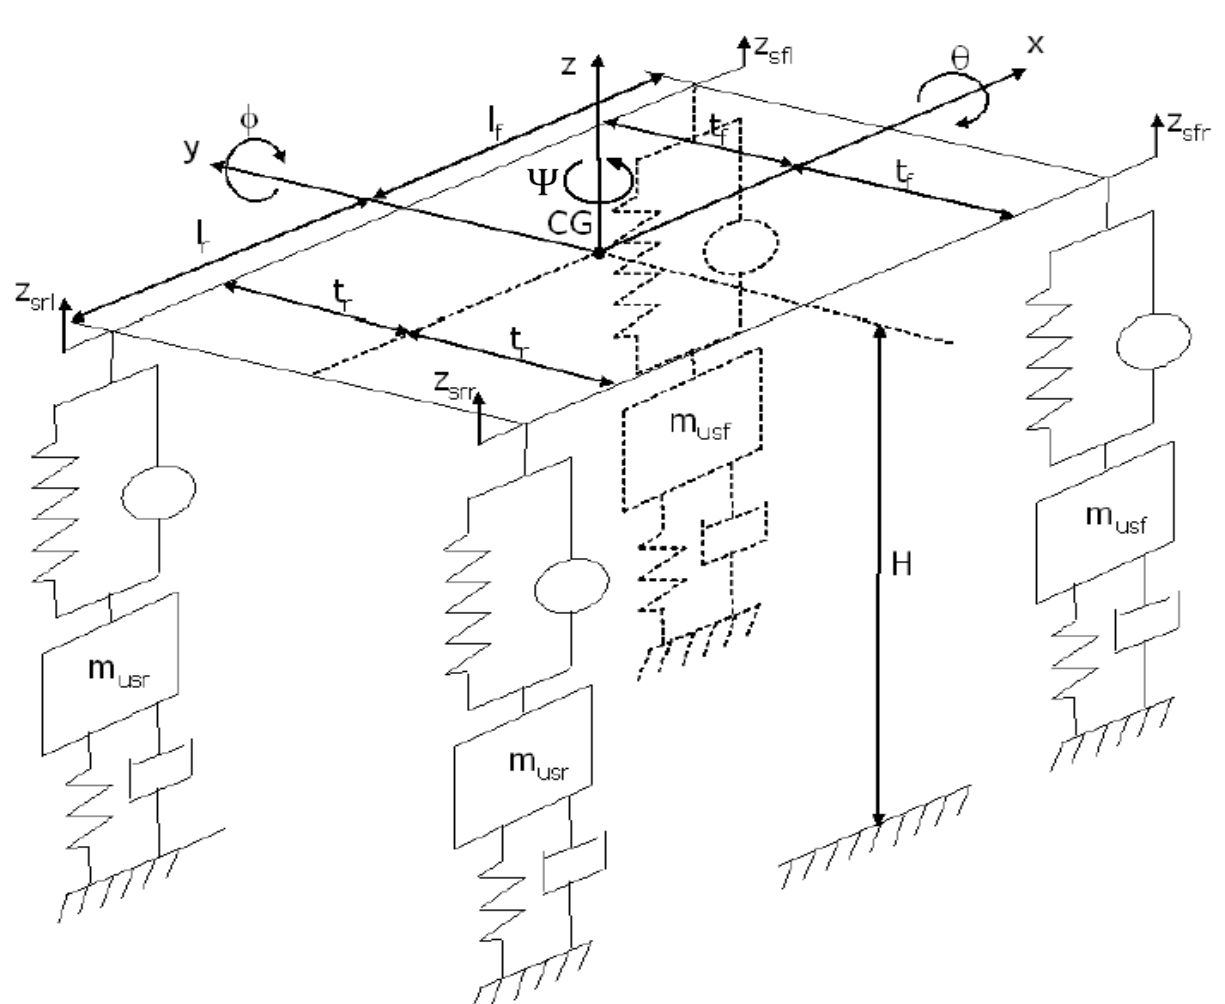
Figure 4. Full-vehicle